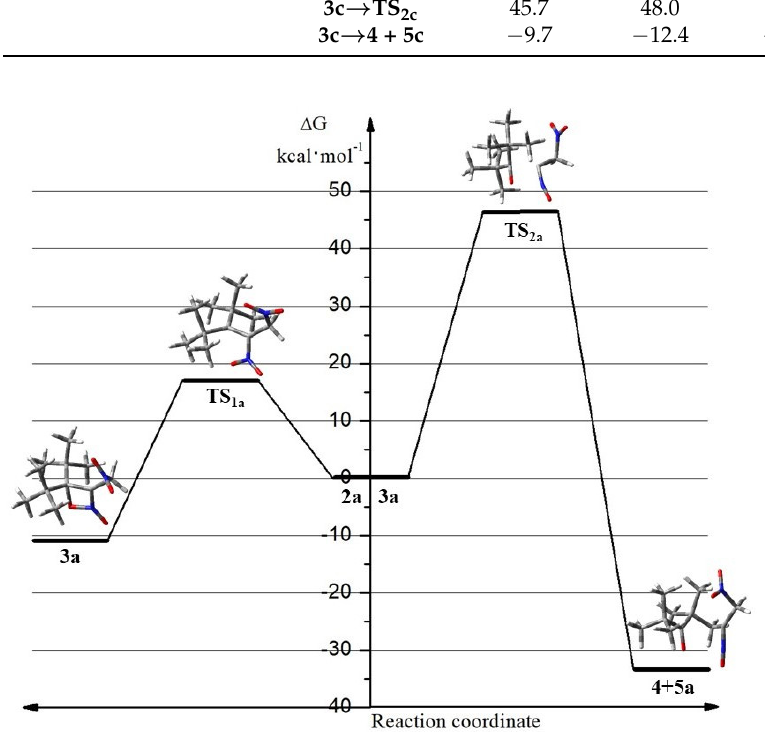
Figure 2. MPWB1K/6-311G(d,p) Gibbs free energy profile ( ∆ G, kcal · mol − 1 ) for the formation of 4-di-tert-butyl-3-nitromethyl-4H-[1,2]oxazete 2-oxide ( 3a ) (left side) and retro-32CA reaction of the 3a (right side). Table 1. The relative electronic energies, enthalpies, Gibbs free energy ( Δ E, Δ H, and Δ G, in basic set, for the stationary points involved in the formation of 4H-[1,2]oxazete 2-oxide derivative ( 3a - c ) and retro-32CA reaction leading di-tert-butyl ketone ( 4 ) and nitrile oxide derivative ( 5a - c ).